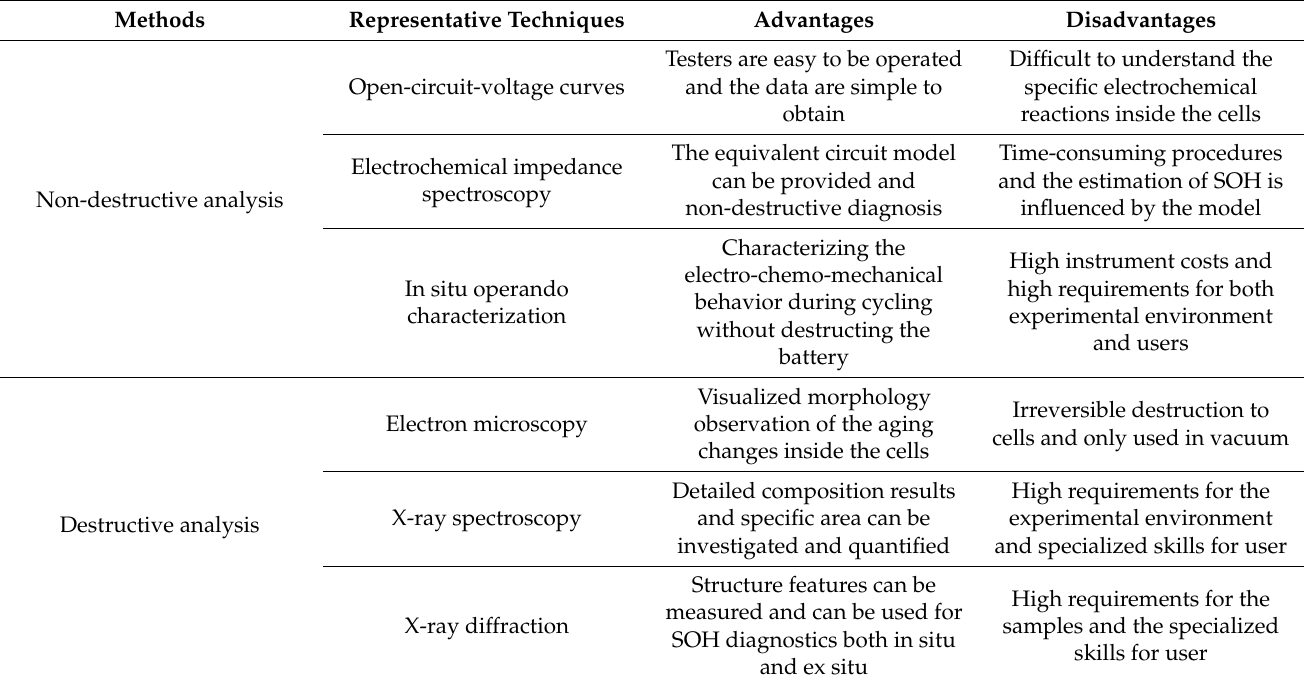
Table 1. Comparison of aging diagnostic